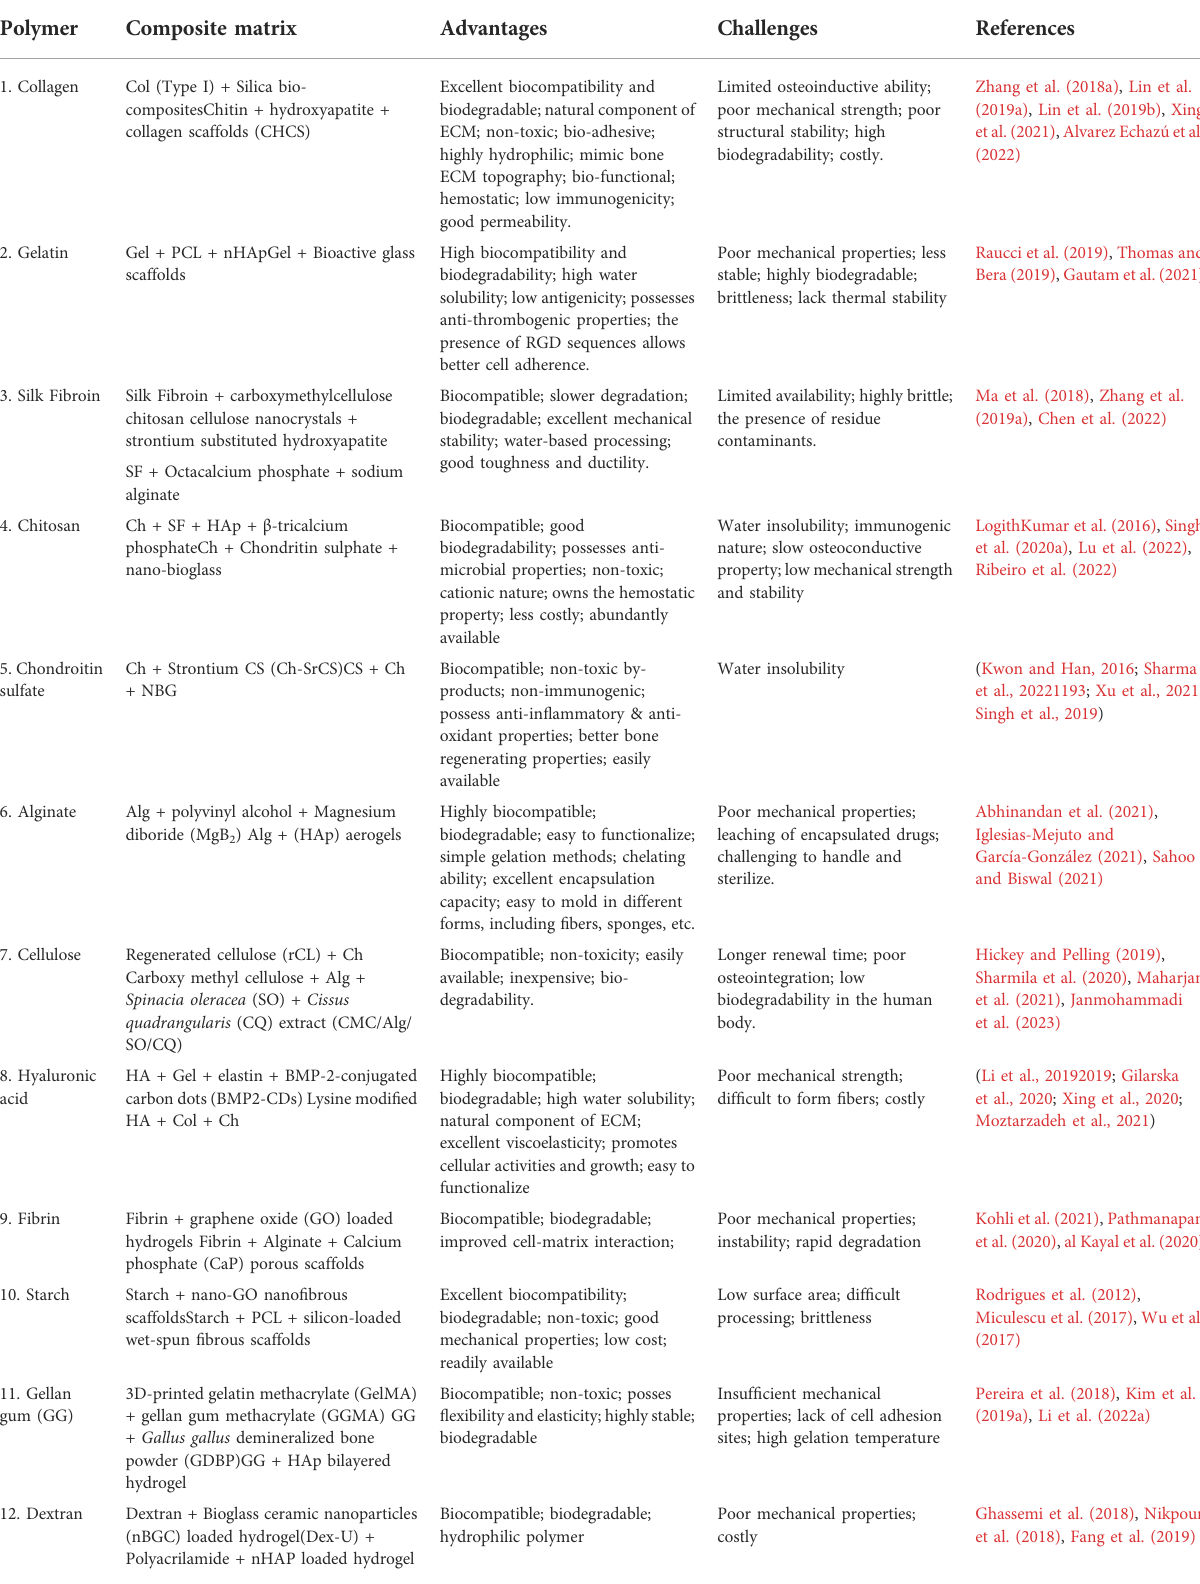
TABLE 1 Advantages and challenges of natural polymeric-based composite matrix for